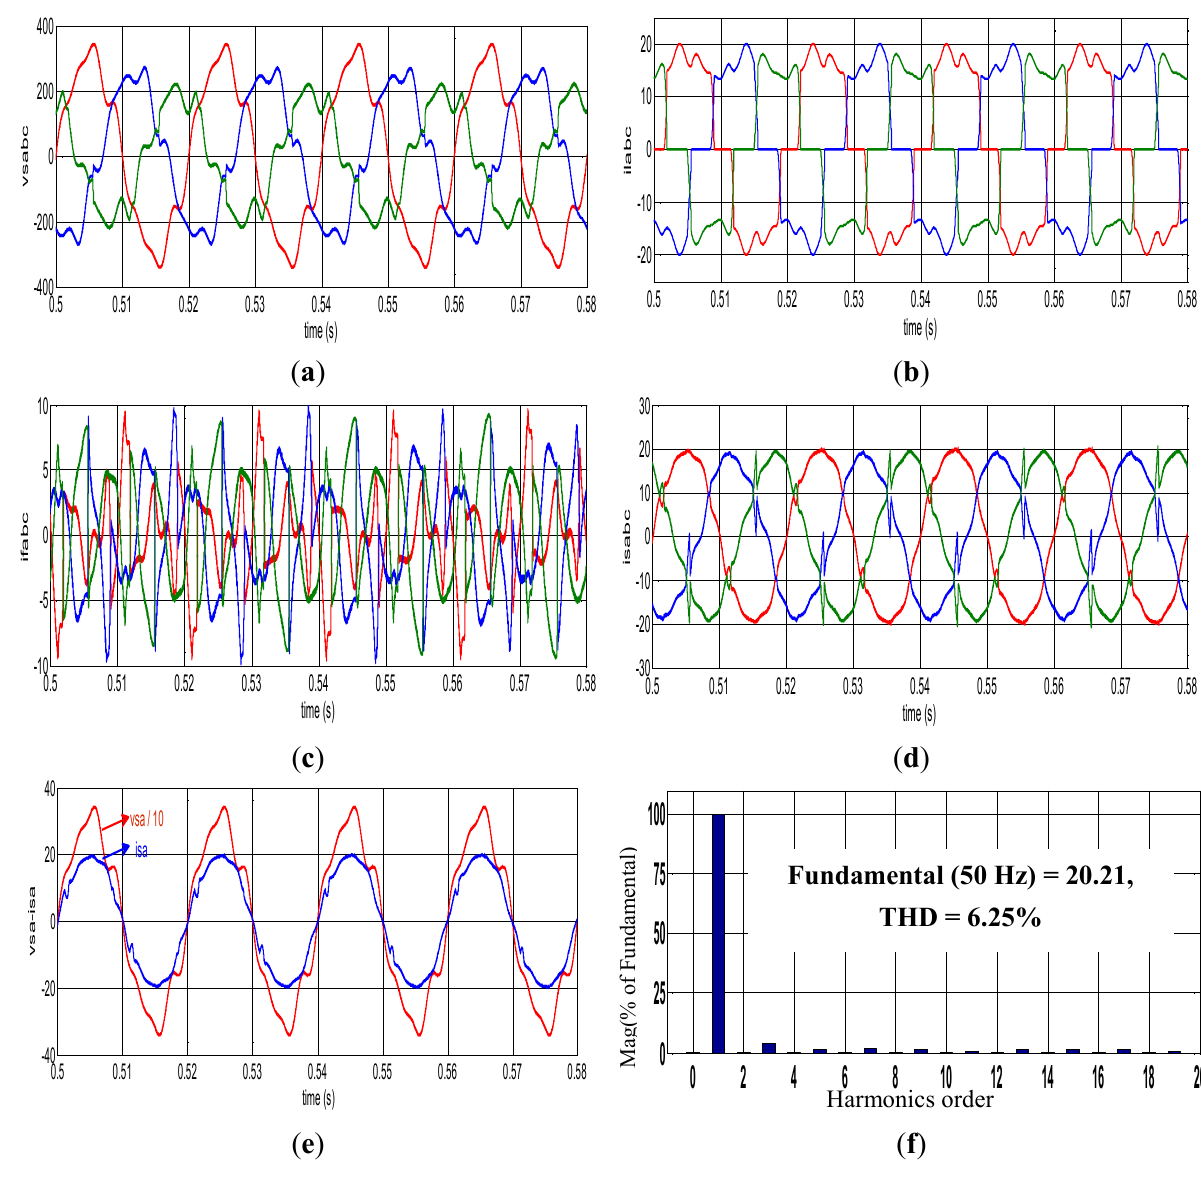
Figure 11. Simulation results for unbalanced distorted grid voltage: ( a ) three-phase line voltages; ( b ) three-phase load currents; ( c ) three-phase filter currents; ( d ) three-phase line currents; ( e ) line voltage and current, phase-a; ( f ) frequency spectrum of line current,